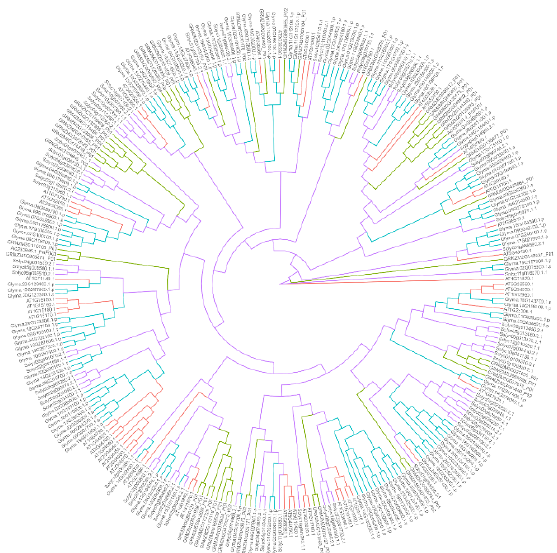
Figure 4. Phylogenetic analysis of multi-antimicrobial extrusion protein (MATE) transporters from G. max , Z. mays , S. lycopersicum and A. thaliana . The amino acid sequences of the MATE transporters identified from G. max , Z. mays , S. lycopersicum and A. thaliana [129–131,134] were aligned using Clustal Omega [126] with default parameters. The phylogenetic tree was constructed using RAxML [127] with 1000 times rapid bootstrapping. The protein model was selected automatically by the maximum likelihood criterion. Table 2. Summary of ABC transporters and MATE transporters identified in di ff erent plant species.